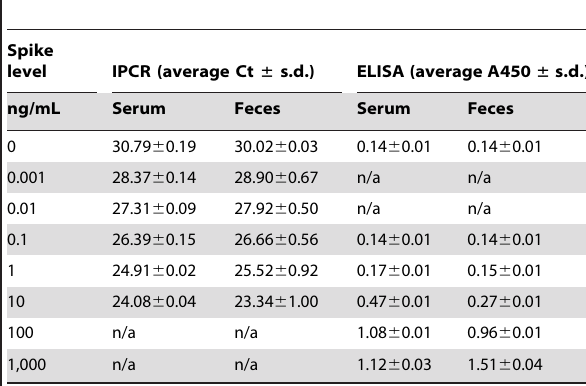
Table 3. Detection of ricin in mouse sera and feces using IPCR and sandwich ELISA.